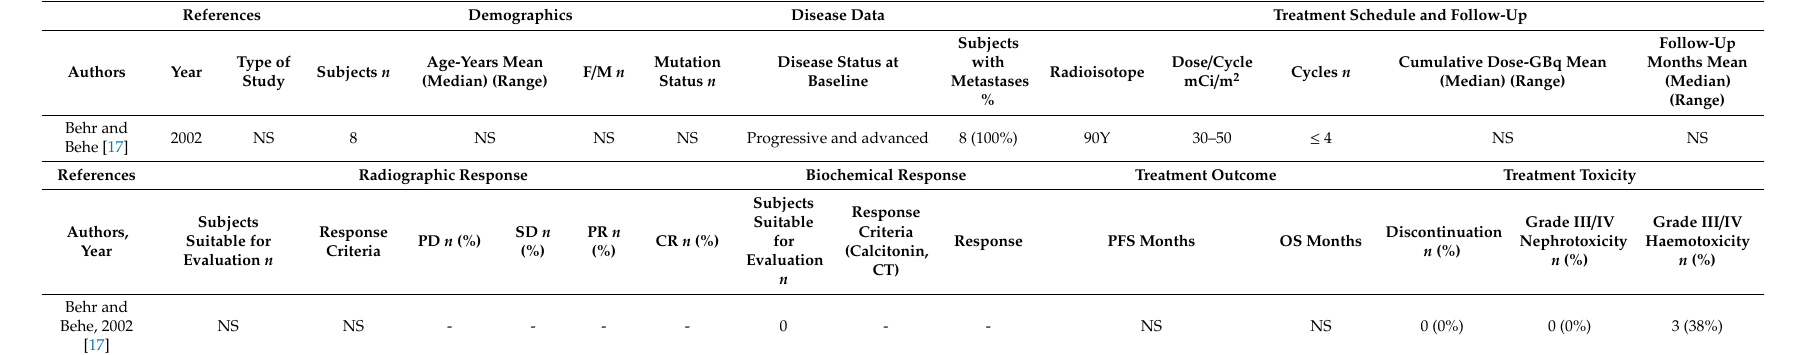
Table 3. PRRT targeting CCK2Rs in